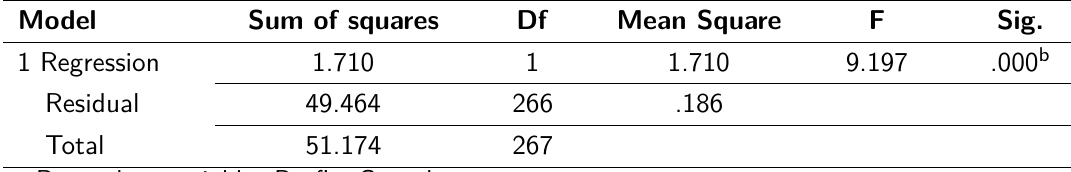
Table 3. ANOVA (service innovations and profit